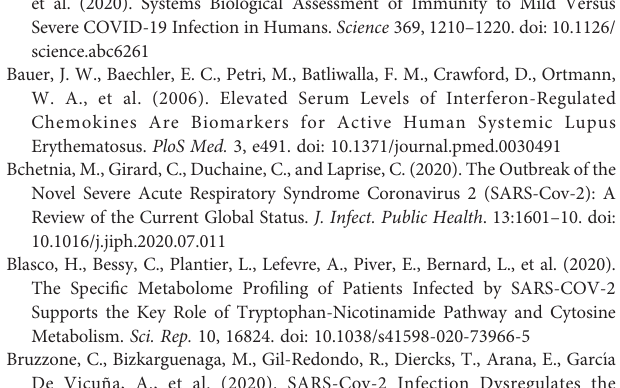
Supplementary Table 6 | Baseline characteristics and clinical data of D-Dimer. Supplementary Table 7 | The negative mode results of ROC analysis for all differential metabolites. Supplementary Table 8 | The positive mode results of ROC analysis for all differential